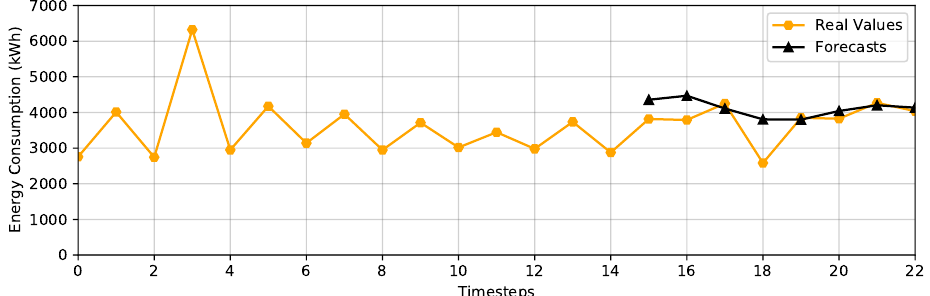
Figure 8. Eight multi-step forecasts for the best candidate model in Method